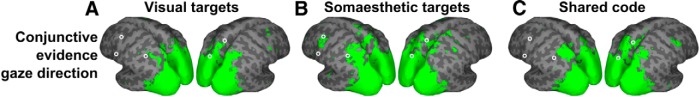
A–C, Gaze-direction coding for planning grasping movements to visual targets (A), somaesthetic targets (B), and irrespective of modality (C). Voxels within the binary map are significant for classification on all four main pairs and cross-classification on the center-sides pair, as determined using the conjunction test. Compare to Figure 4A
 (top row) for an overview of all tuning. Circles indicate ROIs.